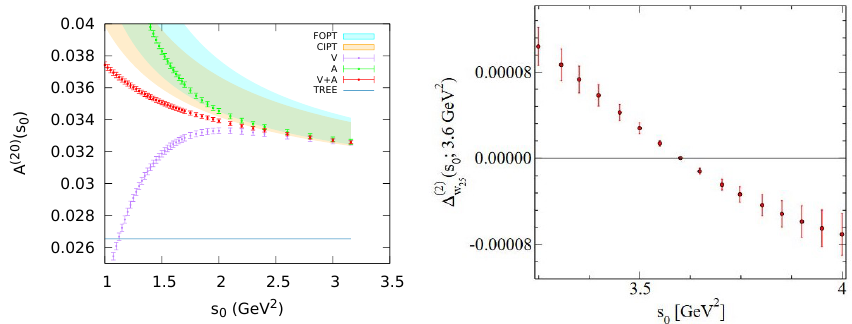
ω Figure 3 . Dependence on s ( s 0 ) for the V (purple), A (green) 0 of the experimental moments A Figure 3. Left panel: s 0 dependence of the LHS of the w (2 , 0) ( x ) = (1 − x ) 2 FESR for the V (purple), J and 1 ( V + A ) (red) channels. The left plot corresponds to the weight ω (0 , 0) ( x ) = 1, and the right 2 A (green) and 1 ( V + A ) (red) channels. The orange and light-blue regions are the CIPT and FOPT one to ω (2 , 0) ( x ) = (1 x ) 2 . The orange and light-blue regions are the CIPT and FOPT perturbative 2 − perturbative predictions for α s ( m τ ) = 0 . 329 + 0 . 020 +0 . 020 predictions for α s ( m 2 τ ) = 0 . 329 [35]. The blue horizontal lines at the bottom indicate the − 0 . 018 parton-model prediction. Taken from Ref. [26]. Right panel: Double di ff erence ∆ (2) w ( s 0 , s ∗ parton-model prediction. data (see text)